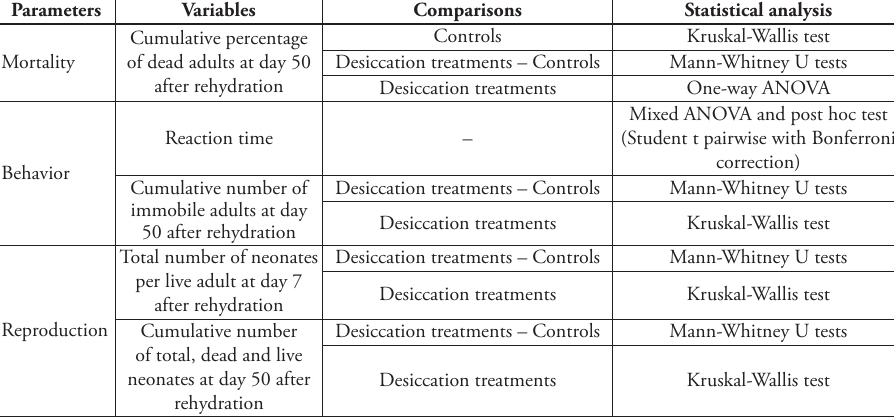
Table 2. Summary of the analyzed parameters, the variables of each parameter and the statistical analysis